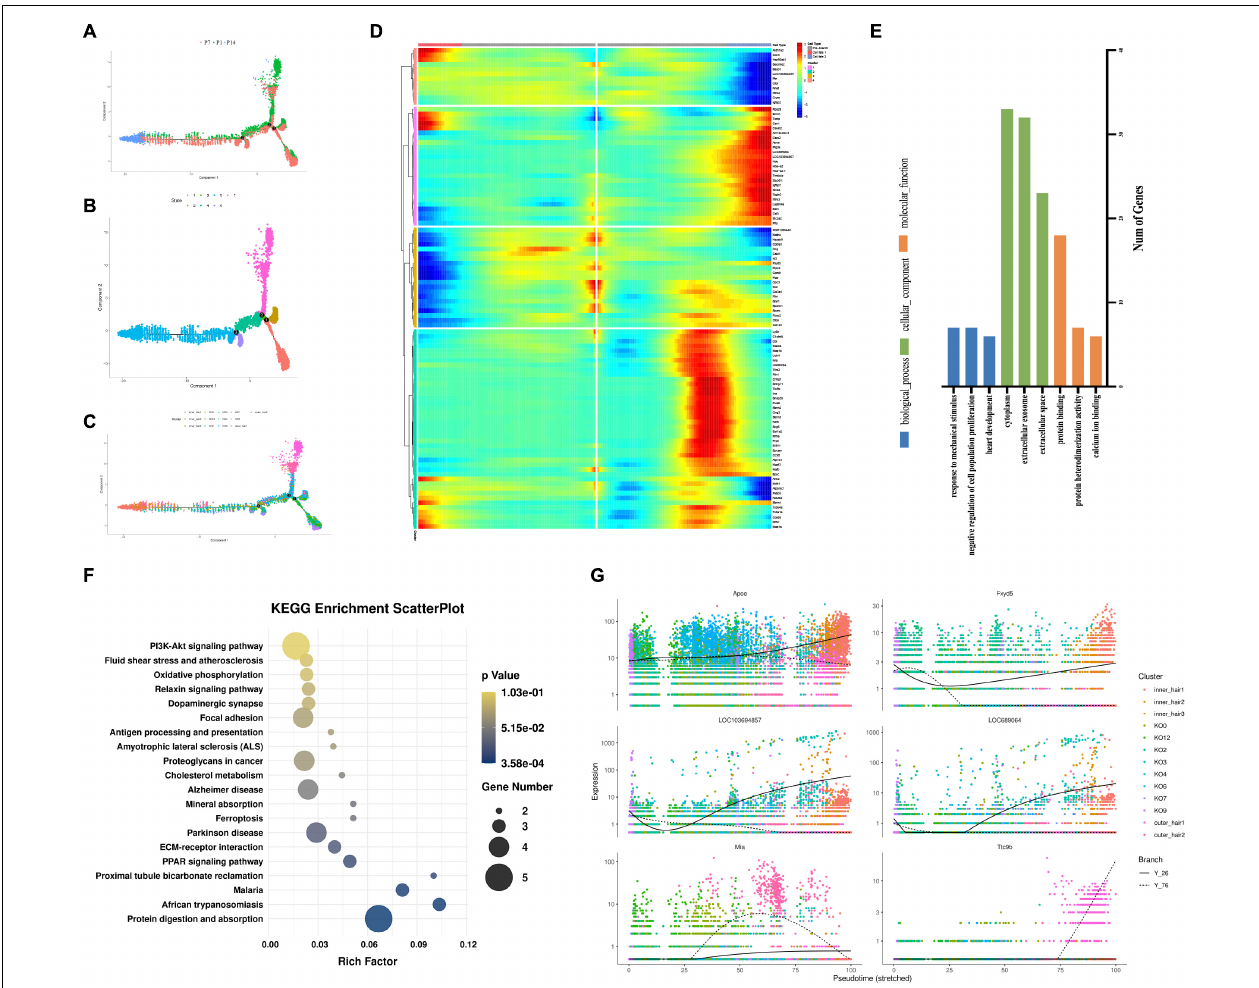
FIGURE 8 | Developmental trajectories of KO cells and inner and outer hair cells. (A–C) Monocle analyses show the development of KO cells and inner and outer hair cells. (D) Heatmap of different blocks of DEGs along the pseudotime trajectory. (E) GO enrichment analysis of genes in Fate 1 and Fate 2 cell fate transitions for KO cells and inner and outer hair cells. (F) Functional enrichment analyses using KEGG pathways in Fate1 and Fate 2 cell fate transitions. (G) Dynamic gene expression with pseudotime